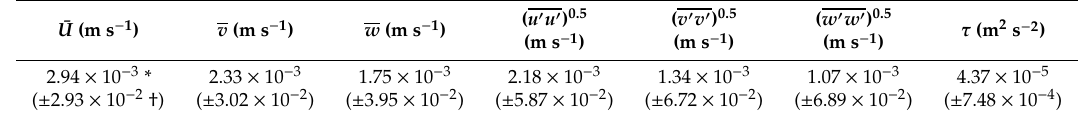
Table 1. Uncertainty estimation for Vectrino.